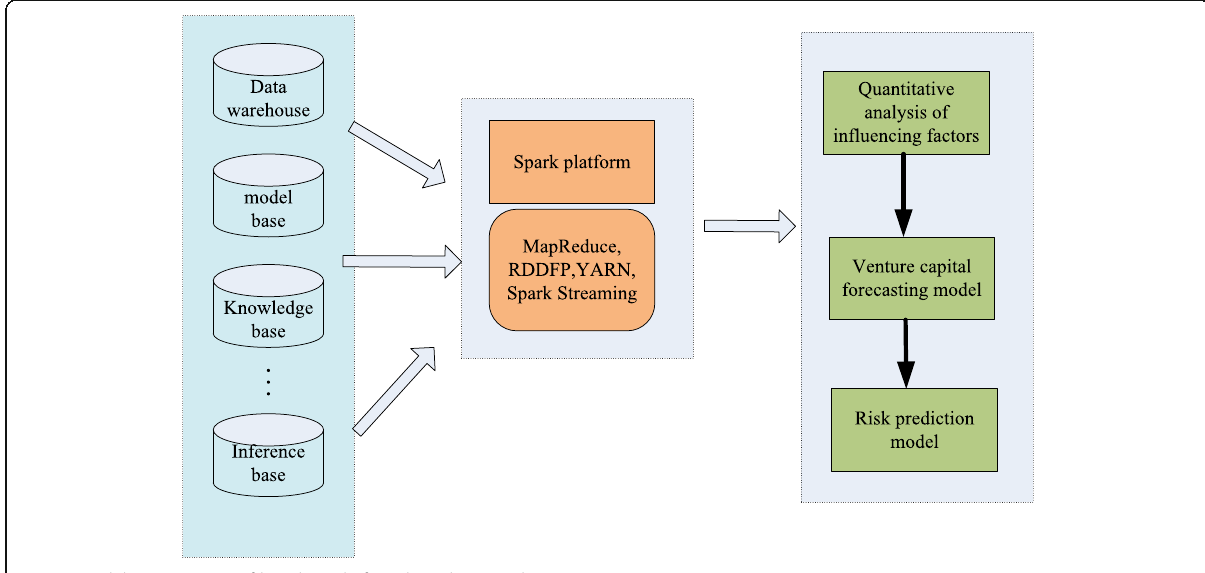
Fig. 2 Model construction of big data platform based on